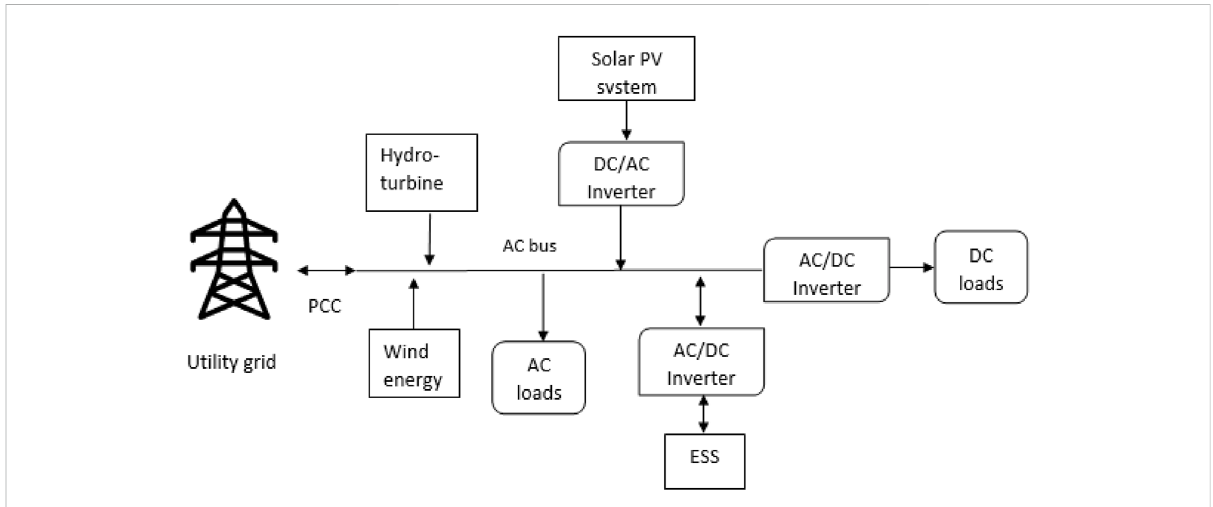
FIGURE 2 AC microgrid structure with AC and DC